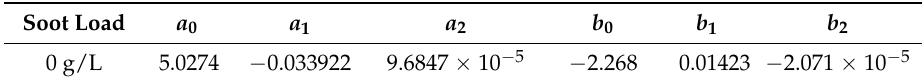
Table 3. Parameter identification results.